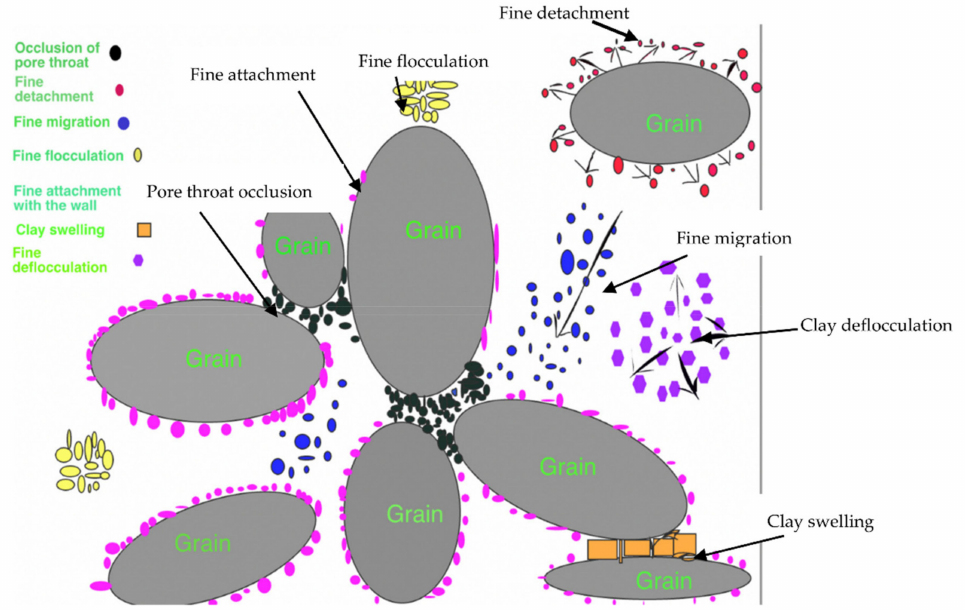
Figure 4. The effects of interaction between the different mechanisms on formation